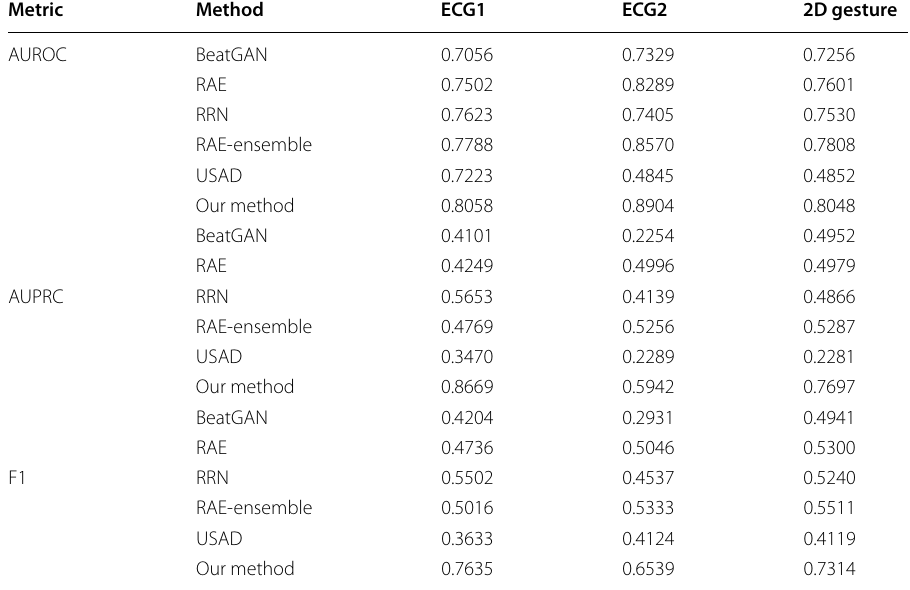
Table 3 Comparative experiments